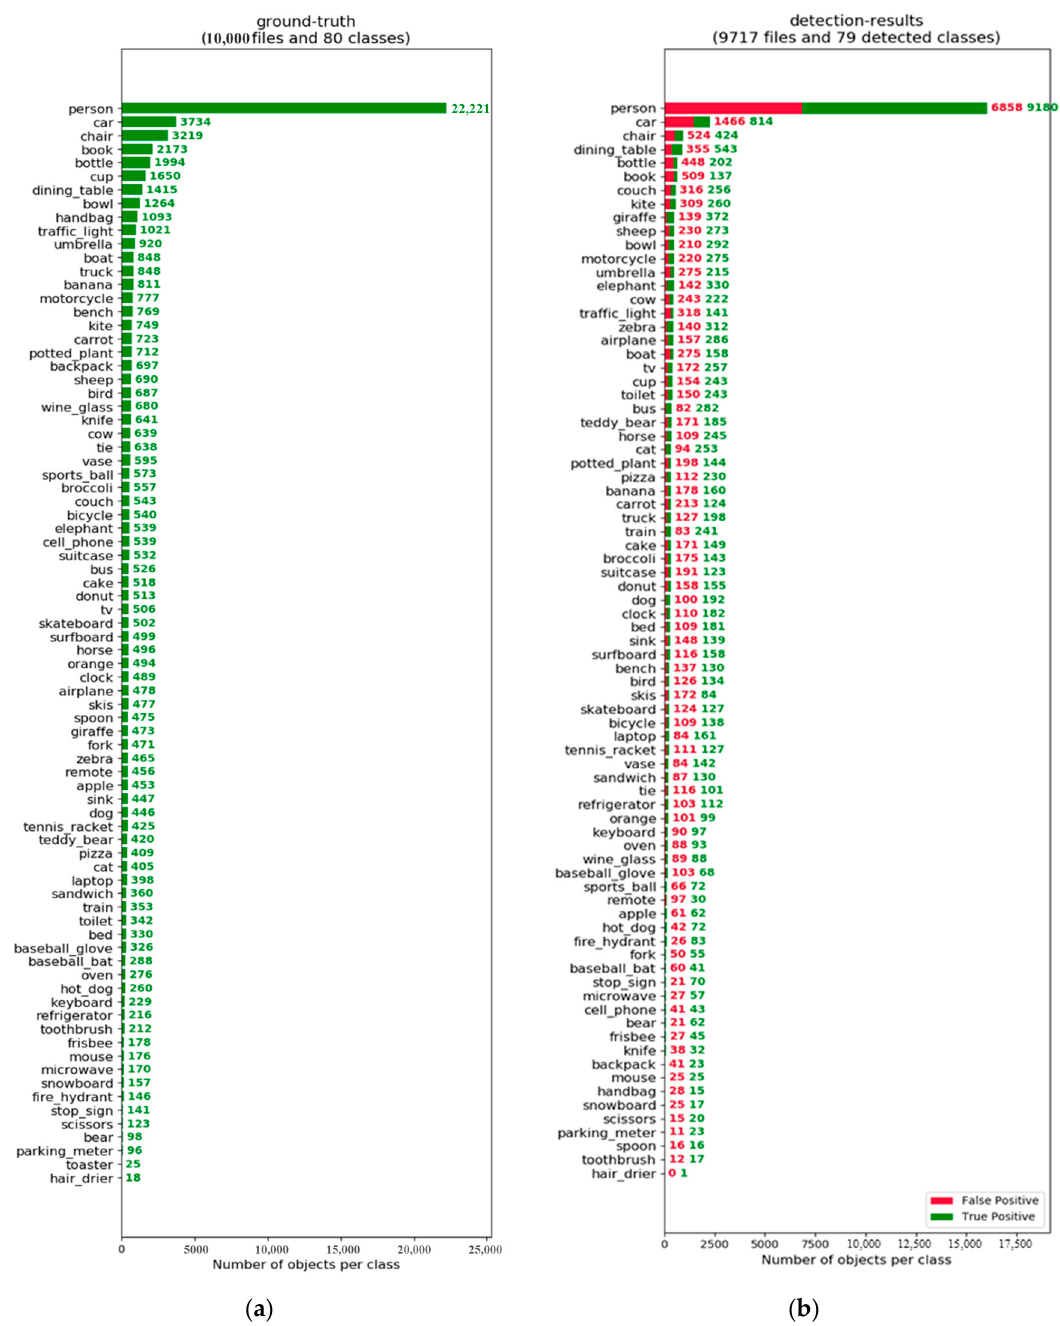
Figure 8. ( a ) Sampled dataset overview. ( b ) The detection results overview.